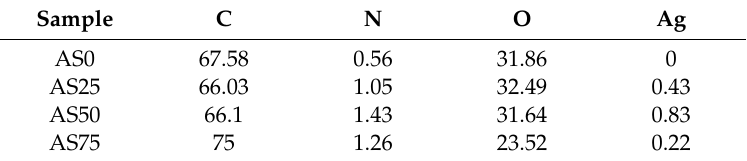
Figure 7. XPS analysis of the composition of the hydrogel, ( A ) AS0, ( B ) AS25, ( C) AS50, ( D ) AS75 Table 3. Analysis of the content of elements in hydrogel by XPS.